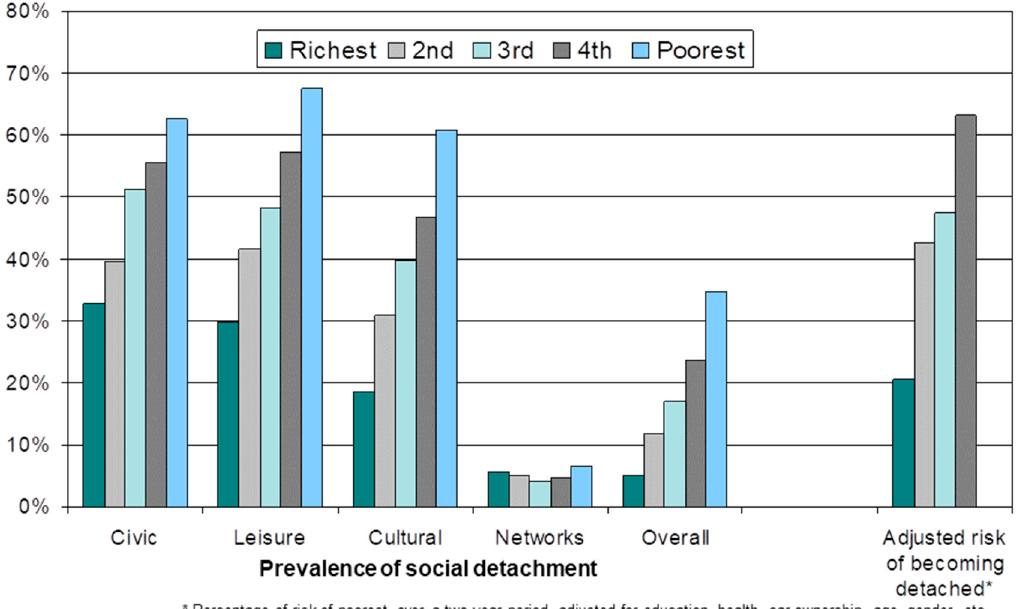
Figure 7. Social detachment, risk of social detachment and wealth.